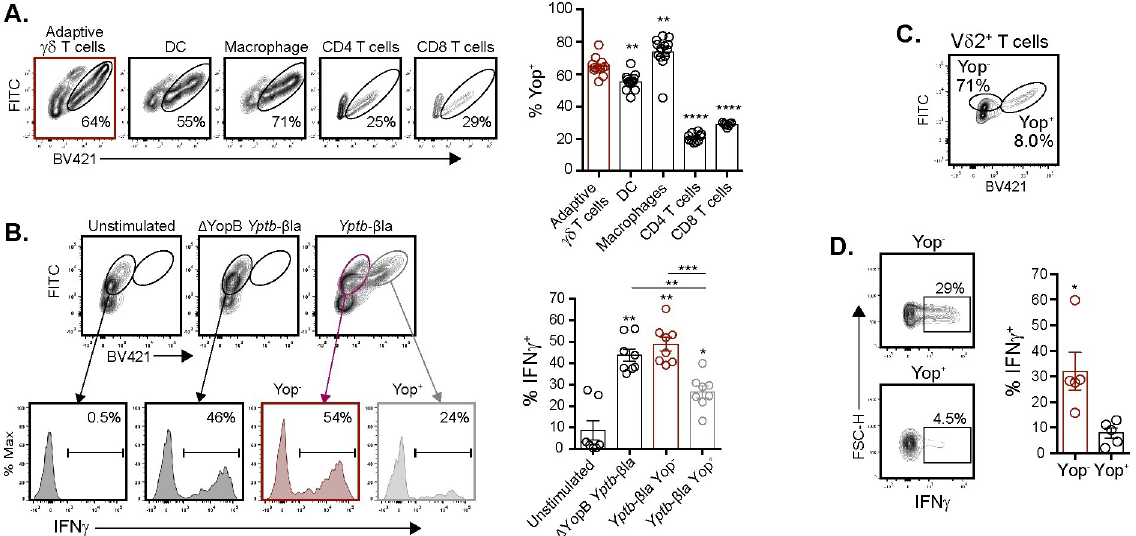
Fig 2. Direct translocation of Yop effectors inhibits the function of murine V γ 4 and human V δ 2 + T cells. MLN suspensions from L . monocytogenes infected mice ( A and B ) or human PBMC ( C and D ) were left unstimulated or stimulated with WT or Δ YopB Yptb - β la as indicated. Cells were loaded with CCF4-AM dye prior to stimulation to measure β -lactamase activity. FITC indicates CCF4-AM loaded cells without translocation (Yop - ) and BV421 indicates CCF4-AM loaded cells with Yop translocation (Yop + ). ( A ) Adaptive γδ T cells (V γ 1.1/2 - CD44 hi CD27 - γδ T cells), DC (CD11c hi MHCII hi ), Macrophages (F4/80 + CD11b + ), and CD4 and CD8 T cells were analyzed for Yop translocation 2 hours post stimulation at an MOI of 10. Representative contour plots are displayed. Yop translocation among the indicated populations is depicted as mean ± SEM and is pooled from 2 experiments with a total of 4–8 mice per group. ( B ) Antibiotics were given 2 hours post-stimulation and brefeldin A was added for the last 5–6 hours of stimulation. V γ 1.1/2 - CD44 hi CD27 - γδ T cells were analyzed for Yop translocation and IFN γ production 24 hours after stimulation. Representative contour plots and histograms are shown. IFN γ production among the indicated populations is depicted as mean ± SEM and is pooled from 3 experiments with a total of 8 mice per group. ( C and D ) Antibiotics were given 2 hours post-stimulation and brefeldin A was added for the last 5–6 hours of stimulation. V δ 2 + T cells were analyzed for Yop translocation and IFN γ production post stimulation. Representative contour plots are displayed and IFN γ production is quantified among Yop + or Yop - V δ 2 + T cells. The graph depicts mean ± SEM and is pooled from 3 experiments with 5 healthy donors per group. ���� p < 0.0001, ��� p < 0.001, �� p < 0.01, and � p < 0.05. An ordinary one-way ANOVA was used for ( A ), a repeated measures one-way ANOVA was used for ( B ), and a paired t-test was used for ( D ). Comparisons were performed to adaptive γδ T cells in ( A ), to unstimulated or as depicted in figure in ( B ), and to Yop + in ( C